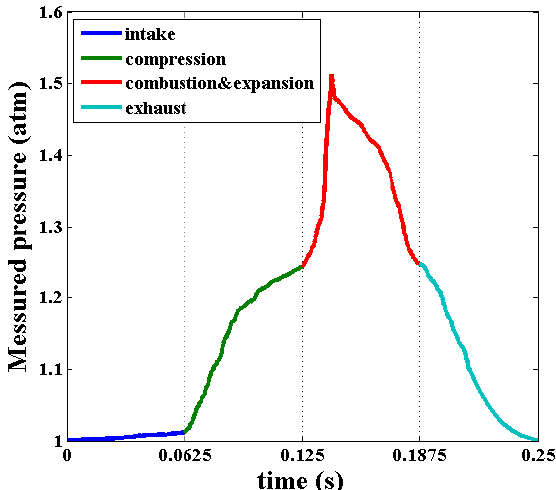
Figure 29. Experimental pressures vs. time for cold state over one cycle.